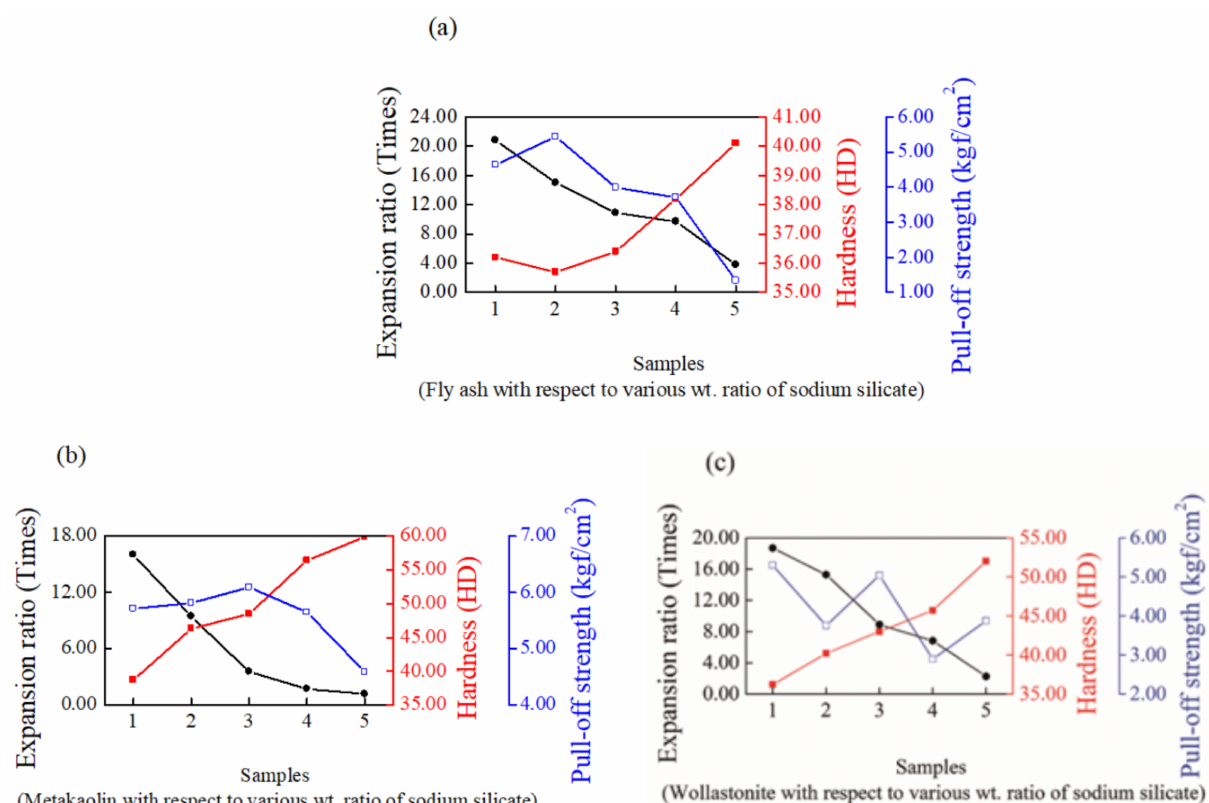
Figure 2. Physical properties of expansion ratio, hardness and pull-off strength of geopolymers containing ( a ) fly ash, ( b ) metakaolin and ( c ) wollastonite at various weight ratios to sodium silicate